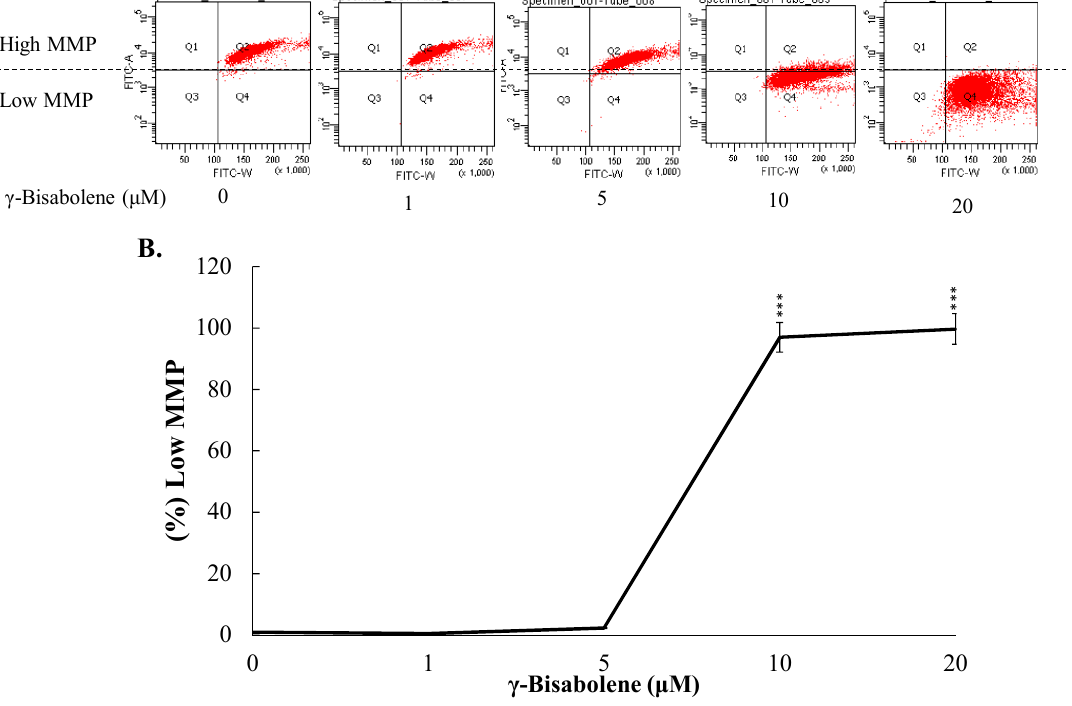
Figure 5. Loss of mitochondrial membrane potential ( ΔΨ M) in human neuroblastom cells treated with γ -bisabolene. TE671 cells were stained using DiOC 6(3), and then measured by flow cytometry ( A ); Relative changes in low MMP of cells treated with γ -bisabolene were shown ( B ). ***, p value < 0.001 compared with untreated cells.